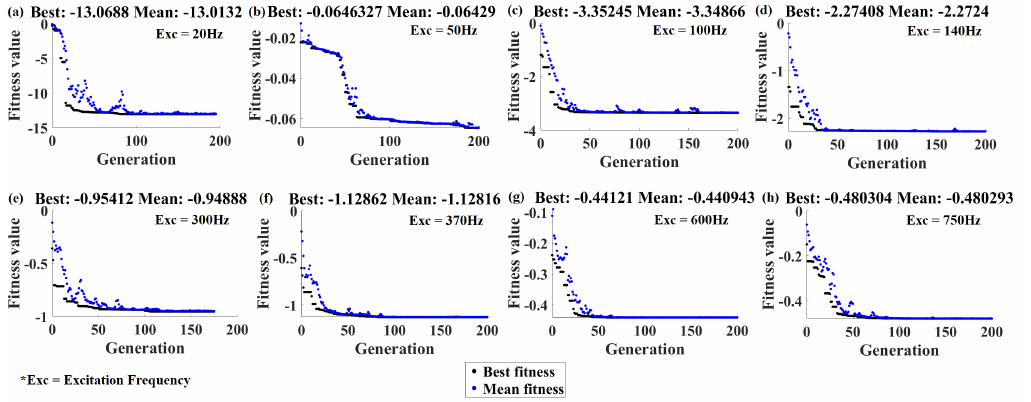
Figure 10. Best and mean fitness data in the generation of the genetic